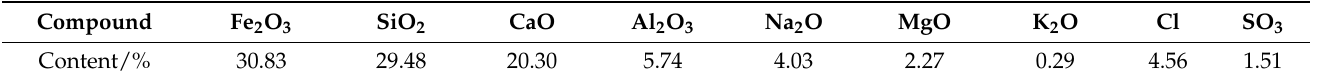
Table 2. Ash composition of MSW.